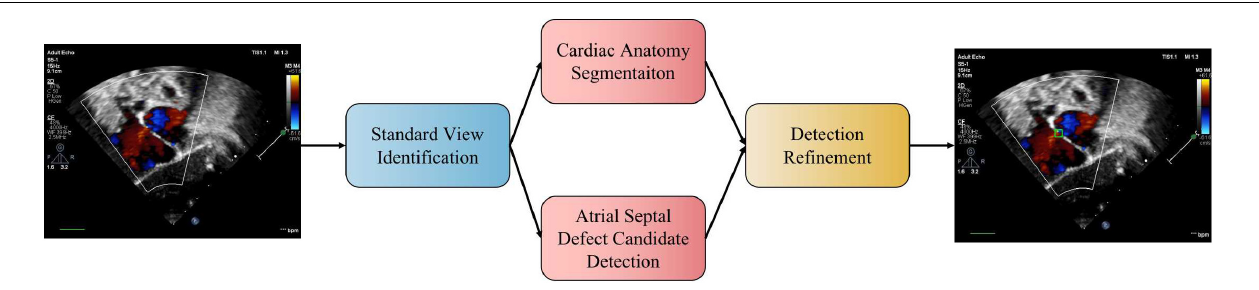
FIGURE 1 | The pipeline of the proposed automatic ASD detection system. In practice, the two stages of cardiac anatomy segmentation and atrial septal defect candidate detection can be run in parallel.